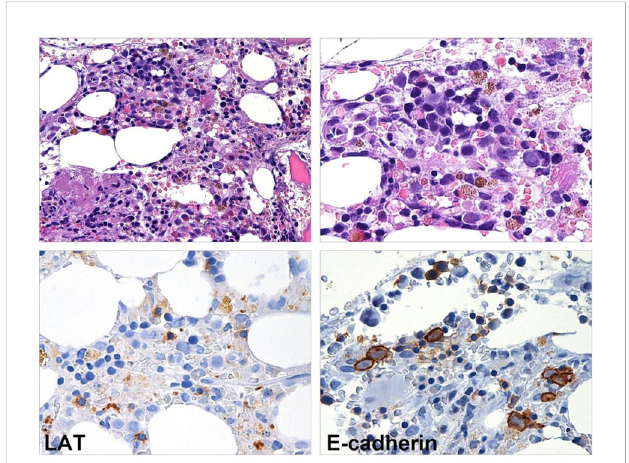
FIGURE 2 BM biopsy performed eight months after CAR T-cell infusion. Myeloid maturation is shifted to the left, granulocytes are rare and hyposegmented. The megakaryopoiesis is hypoplastic (LAT stain) and erythroid precursors show megaloblastoid features (E-caherin stain).